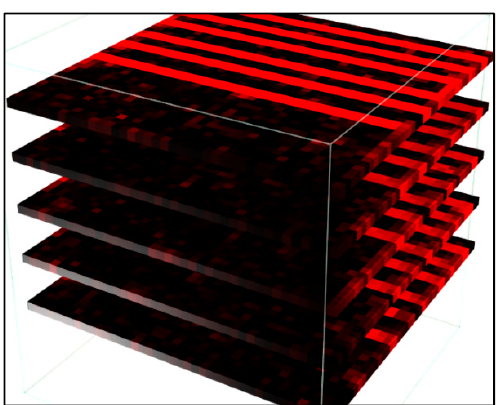
Figure 6. Layered view of the magnetic sample corresponding to g = 0.69 and P / Y = 0. Red indicates magnetic alignments of stripes in the − x direction (from left to right) and black indicates alignments in the + x direction (from right to left).